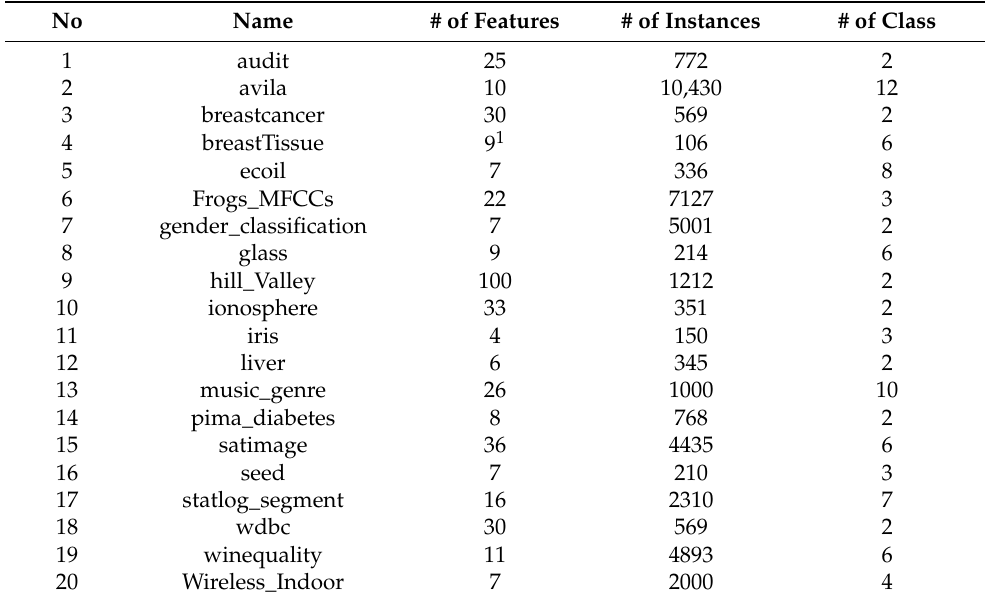
Table 1. List of benchmark